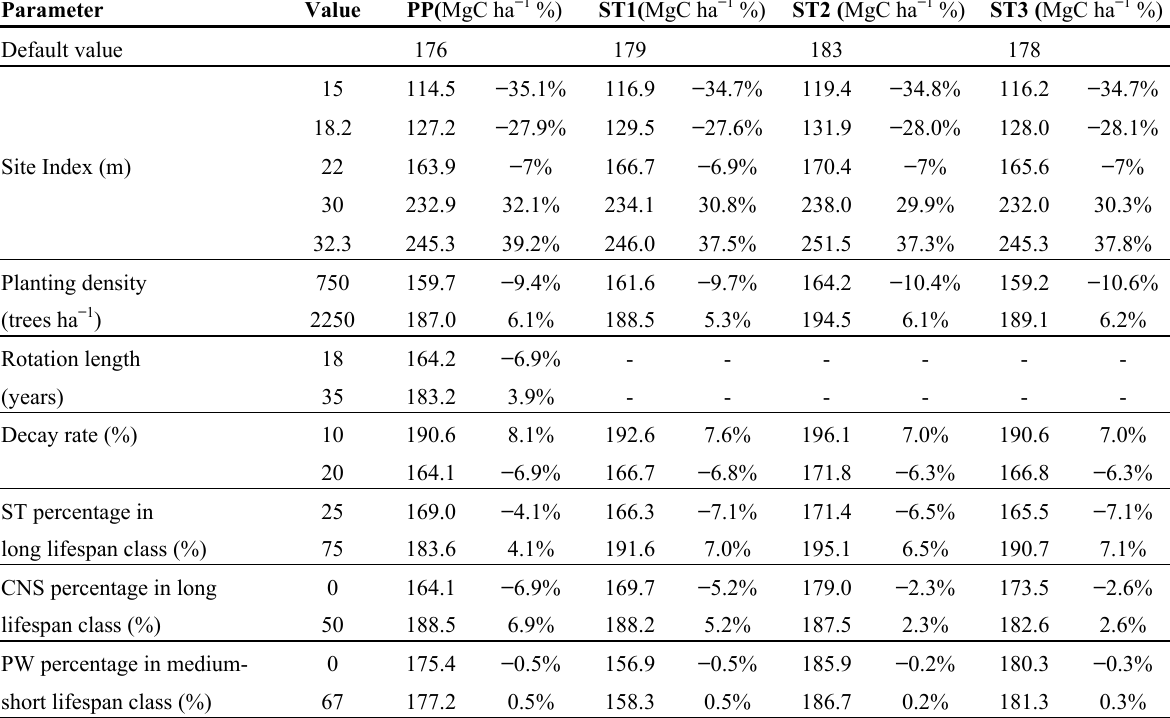
Table 6. Sensitivity analysis of average net carbon stock for selected parameters under different silvicultural scenarios over a ~200 year simulation